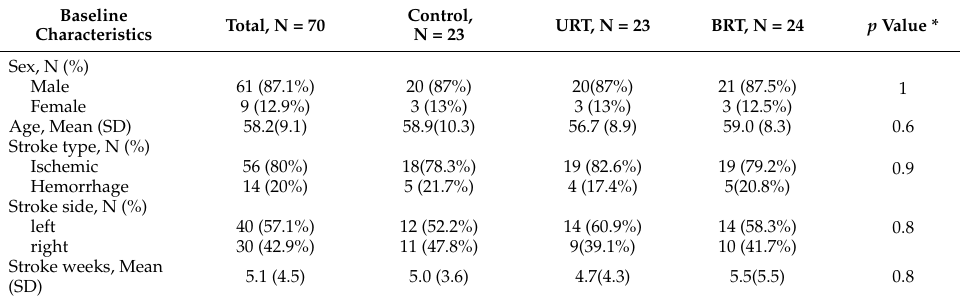
Table 1. Demographic and clinical characteristics of treated subjects.